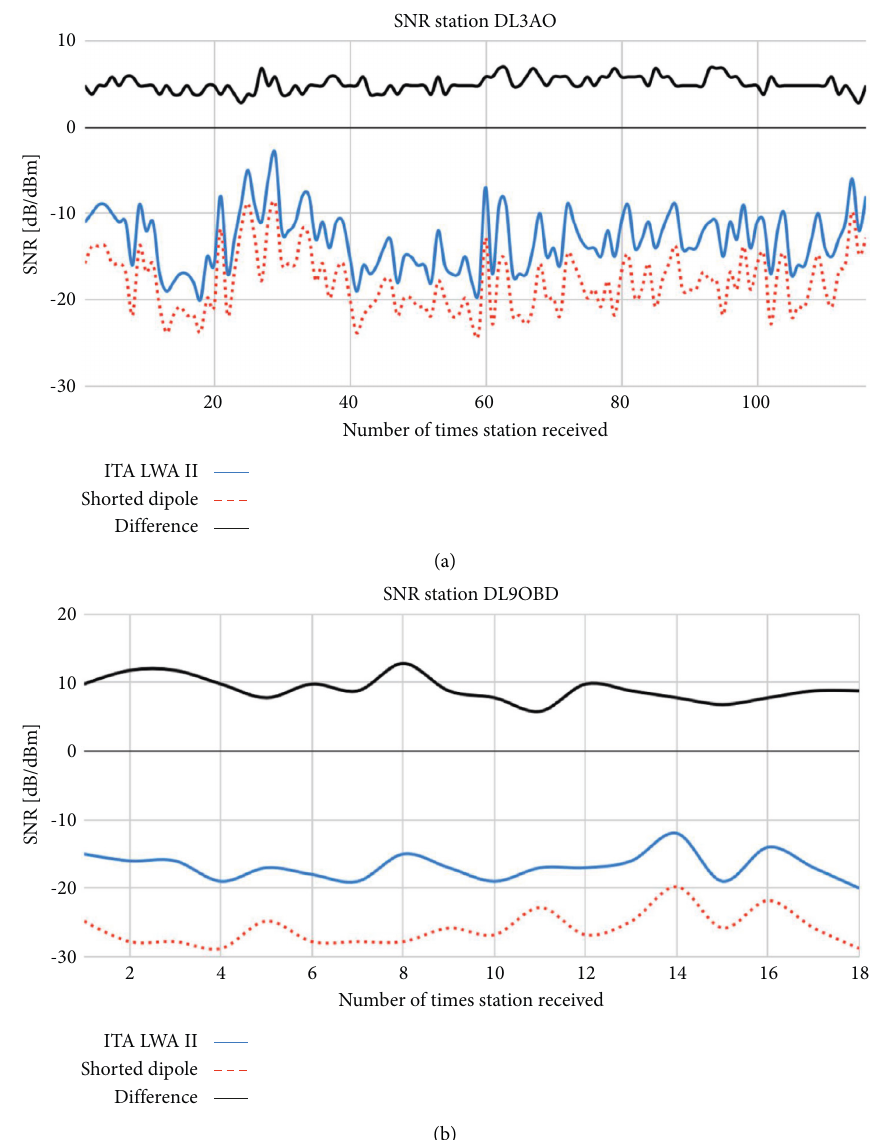
Figure 5: The SNR values of both 160-m antennas for two received stations. The solid blue line is the ITA LWA II antenna, and the dotted red line is the adapted shorted dipole. The difference between both SNR values is shown at the top of both charts as a solid black line. (a) Received SNR values of station DL3AO. (b) Received SNR values of station